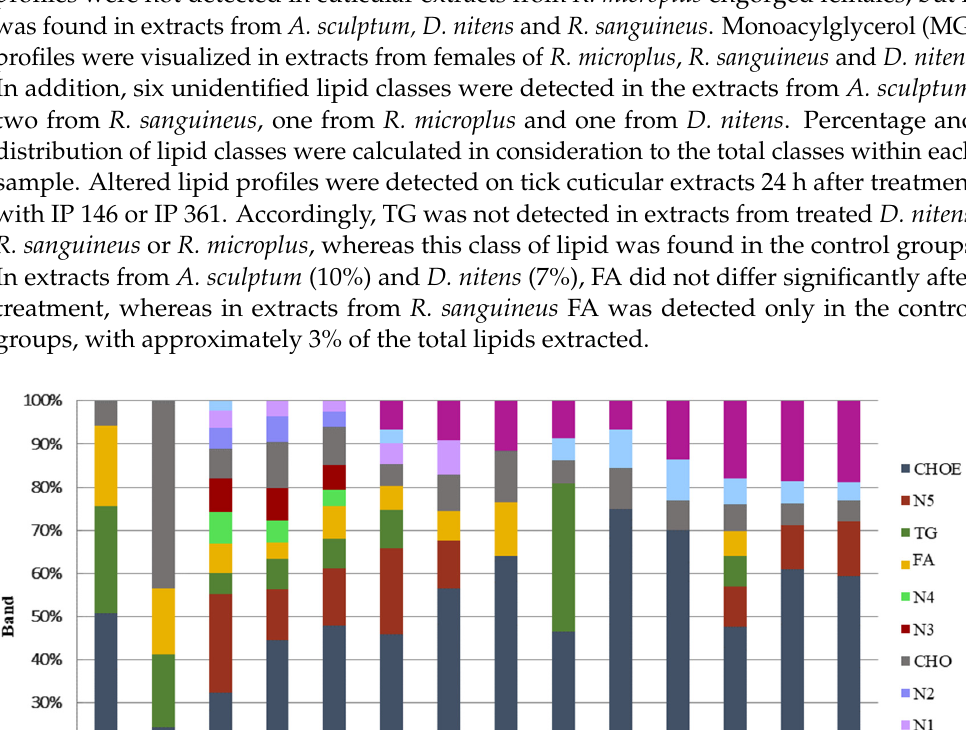
Figure 4. Percent of neutral lipids detected on the tick cuticle ( Amblyomma sculptum (As), Dermacentor nitens (Dn), Rhipicephalus microplus (Rm) or Rhipicephalus sanguineus s.l. (Rs)) 24 h after treatment with aqueous suspensions of Metarhizium robertsii IP 146 (Mr), Beauveria bassiana IP 361 (Bb) or 0.01% Tween 80 (Ctr). Cholesterol-ester (CHOE), triacylglycerol (TG), fatty acids (FA), cholesterol (CHO), monoacyl-glycerol (MG) and unidentified (N).